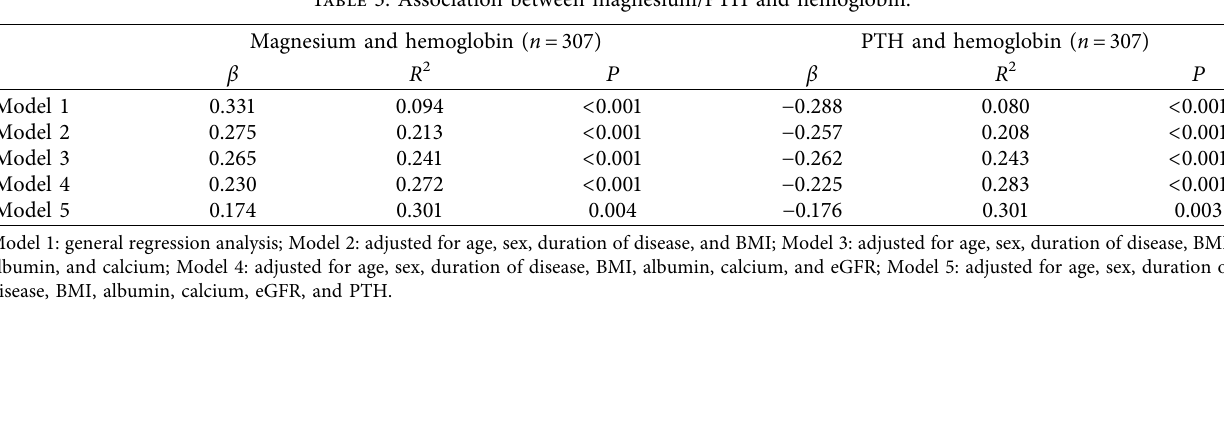
Table 3: Association between magnesium/PTH and hemoglobin. Magnesium and hemoglobin ( n � 307)